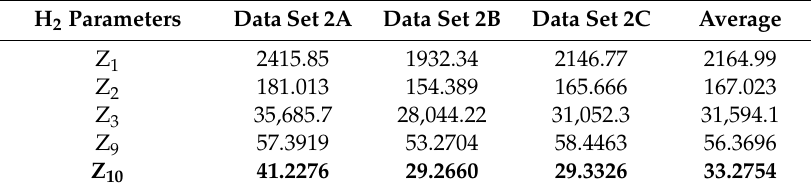
Table 6. Average across the nine SA runs for the µ * values of each data set with the 0.5 wt% Pt, 25 wt% Co / Al 2 O 3